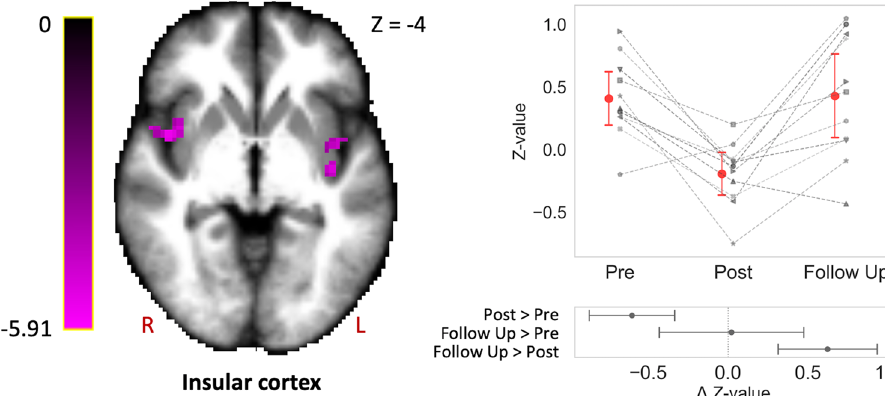
Fig. 3 Connectivity in bilateral insular cortex is decreased after space fl ight and normalizes in the long-term. The bilateral insular cortex showed decreased participation in whole-brain connectivity at post fl ight compared to pre fl ight, which normalized back to pre fl ight levels 8 months after return from space. Signi fi cant clusters are scaled by t -statistic and slice coordinates are represented in MNI space. The plot illustrates cosmonaut-speci fi c (gray) intrinsic connectivity contrast (ICC) changes in the insular cluster (red: mean). Subplots summarize the estimated difference between pairs of timepoints. Error bars indicate 95% con fi dence intervals. Statistical signi fi cance is based on p < 0.005 uncorrected at the voxel level followed by p < 0.05 corrected for family-wise error at the cluster level ( n = 11). R right, L region and bilateral pre- and postcentral gyri, as well as a sus- The complementary Bayesian analysis revealed strong evidence tained increase in connectivity with the left inferior frontal gyrus in favor of the alternative hypothesis for cosmonauts, con fi rming and left angular gyrus (Fig. 5, Table 2). Results for the bilateral the pre- to post fl ight connectivity changes described above, while insula showed that connectivity with middle cingulate cortex, it revealed evidence for the null hypothesis in controls, indicating bilateral pre- and postcentral gyri, central operculum bilaterally, stable connectivity values across time for the participants who and bilateral temporo-parietal junction (encompassing supra- stayed on Earth (Supplementary Table 2). Two connectivity marginal gyrus and superior temporal gyrus) decreased post fl ight values showed anecdotal evidence for a change in controls and normalized (i.e., increased) from post fl ight to follow-up (thalamus — right superior frontal gyrus: BF 10 (error) = 1.02 (0.005), and right angular gyrus — left inferior frontal gyrus: (Fig. 5, Table 2). Additionally, the bilateral insula showed a BF 10 (error) = 1.53 (9.23 − 4 ). However, these remained borderline post fl ight connectivity increase with the left angular gyrus that values and the evidence in the cosmonaut group is much stronger normalized (i.e., decreased) from post fl ight to follow-up (Fig. 5, (thalamus — right superior frontal gyrus: BF 10 (error) = 548 Table 2).